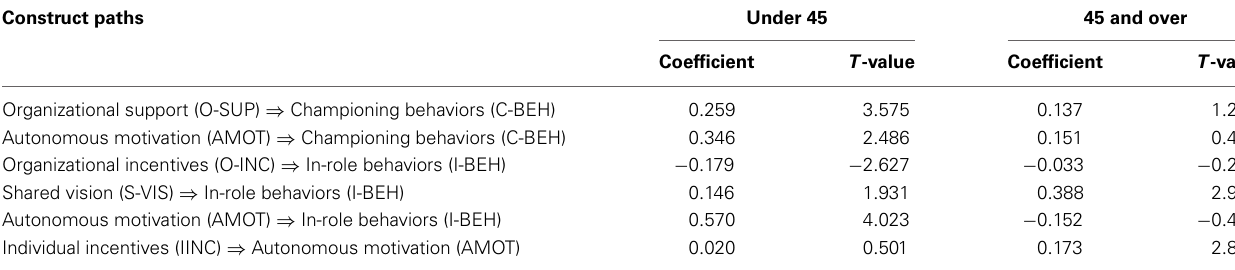
Table 10 | Construct paths w/opposite significance and regression differences >